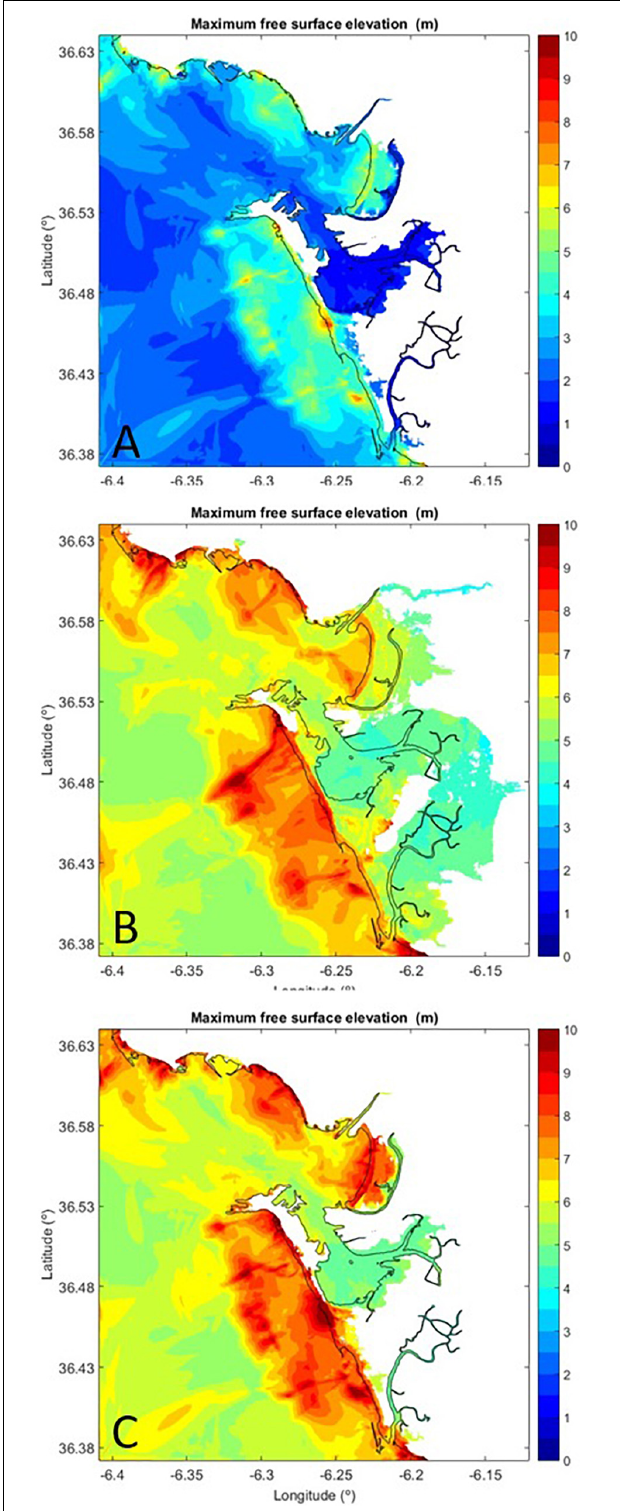
FIGURE 13 | Importance of using tides in the simulations. (A) low tide propagation. (B) high tide propagation. (C) low tide propagation and tide added